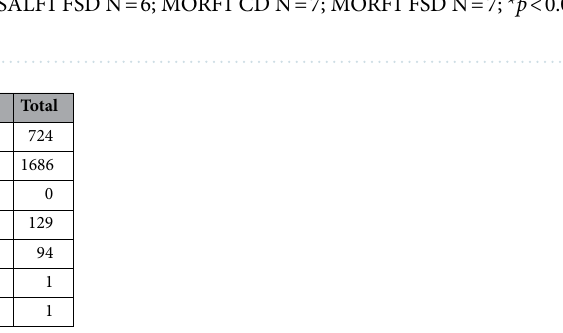
Table 1. Number of differentially expressed genes that reach significance comparing F0 treatment x dietary condition. q value <